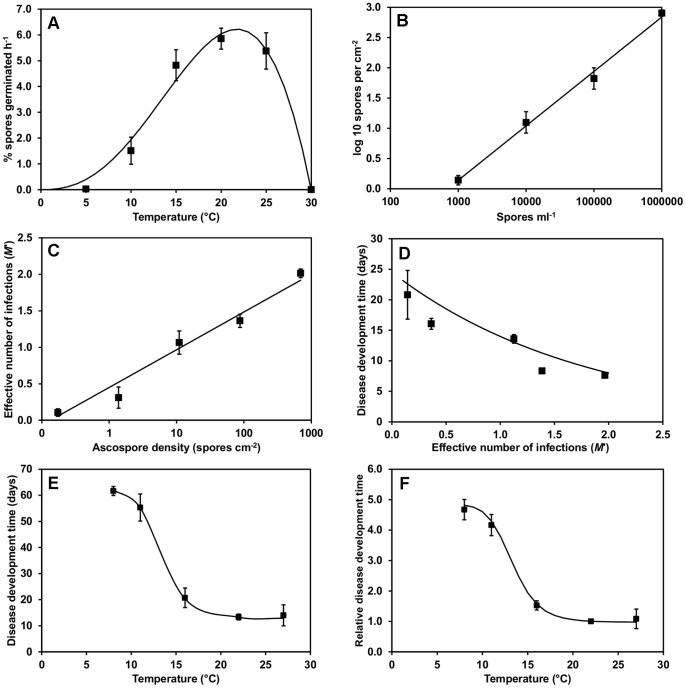
Fitted relationships used in the S. sclerotiorum infection and disease development model in lettuce derived for A) temperature and mean rate of S. sclerotiorum spore germination h−1; B) S. sclerotiorum ascospore suspension concentration (spores ml−1) applied to lettuce plants and mean final spore density (cm−2) measured on leaves; C) mean S. sclerotiorum ascospore density (cm−2) and effective number of infections; D) effective number of S. sclerotiorum infections and mean disease development time (days to first symptoms); E) temperature and mean S. sclerotiorum disease development time (days) and F) temperature and relative S. sclerotiorum disease development time. Points represent observed data, lines represent fitted functions. Error bars are the standard error of the mean (three replicates).